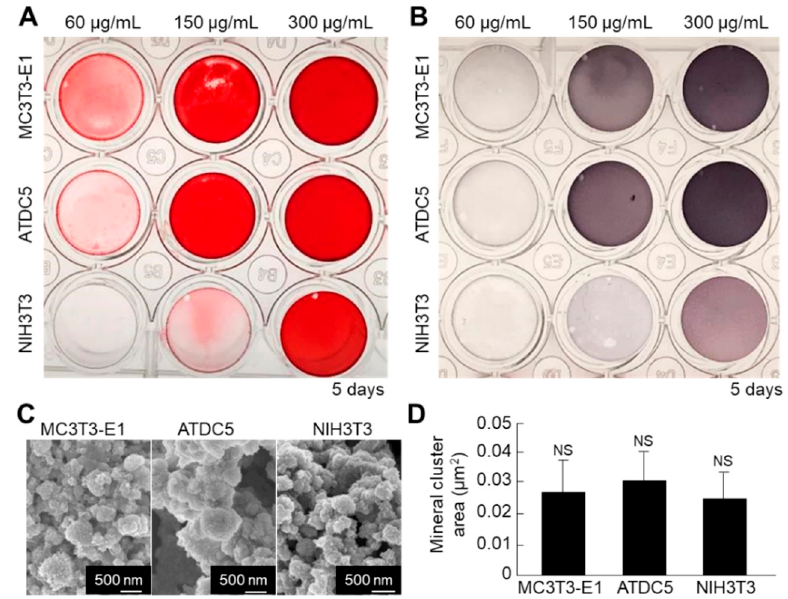
Figure 9. ( A , B ) Comparative analysis of mineralization ability of cell nanofragments from three different types of cells (ATDC5 pre-chondrogenic cells, MC3T3-E1 osteoblastic cells, and NIH3T3 fibroblasts). ARS ( A ) and ALP staining ( B ) of the nanofragments incubated in α -MEM supplemented with 10 mM β -glycerophosphate for 5 days. Note a more rapid mineralization ability of the cell nanofragments derived from MC3T3-E1 and ATDC5 cells, compared to those from NIH3T3 fibroblasts. Note also that even non-mineralizing cells (fibroblasts) are able to promote mineralization after being fragmented. ( C ) SEM images of the mineral structures formed from nanofragments from the three cell types, after treatment with NaClO. ( D ) Graph shows the quantitative analysis of the mineral cluster area, indicating a similar size of minerals independently of the cell source. NS = non-significant, one-way ANOVA.